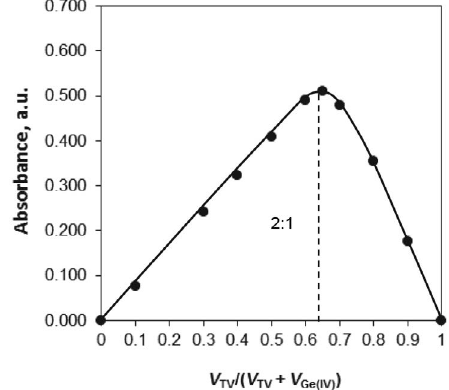
Figure 5. Determination of the molar ratio (n) Ge(IV):TV by the method of continuous variations; C Ge(IV) + C TV = 6.0 × 10 −5 mol L –1 ; C 4-NC = 5.0 × 10 –4 mol L –1 ; pH = 4.0; λ = 420 nm; τ = 2